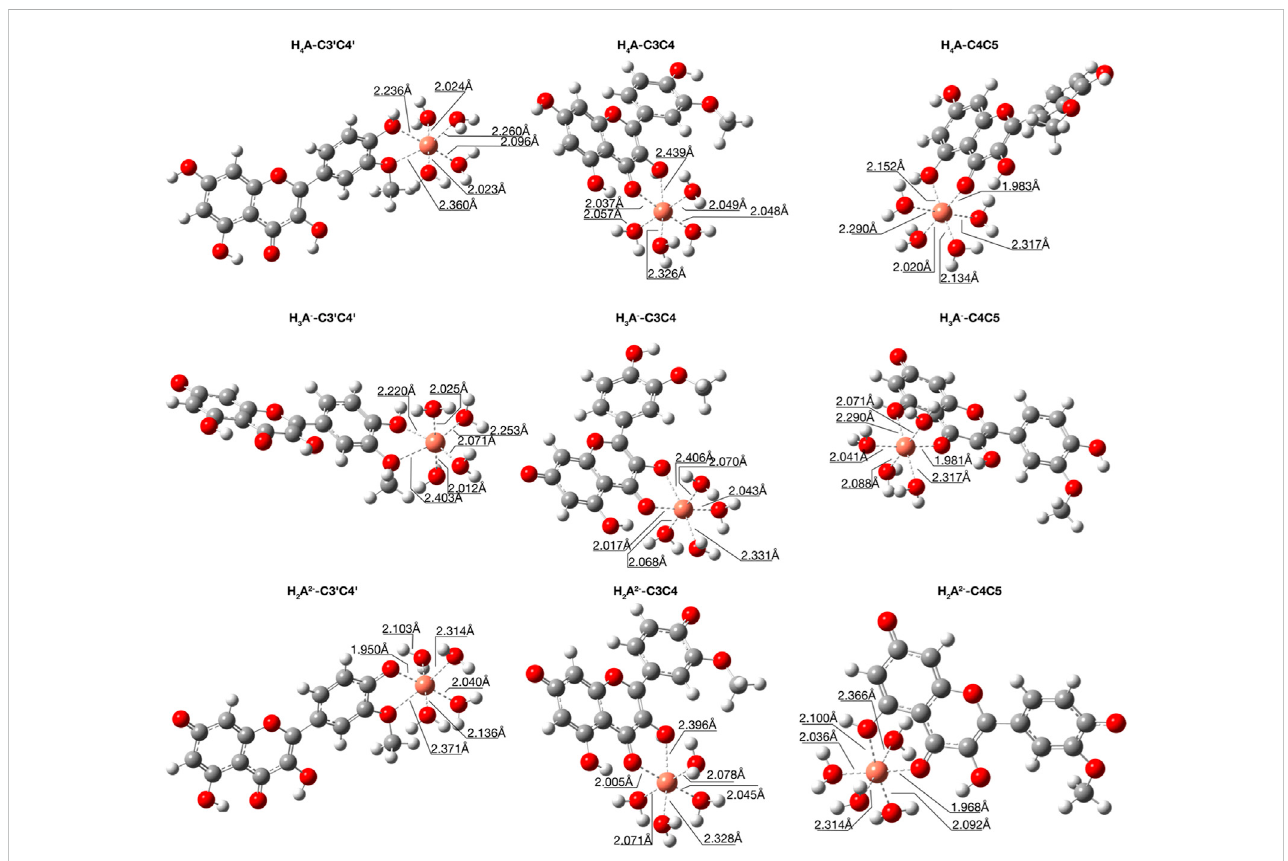
Structures for the most stable 1:1 complexes between Cu 2+ and the neutral and charged species of isorhamnetin in water solvent.